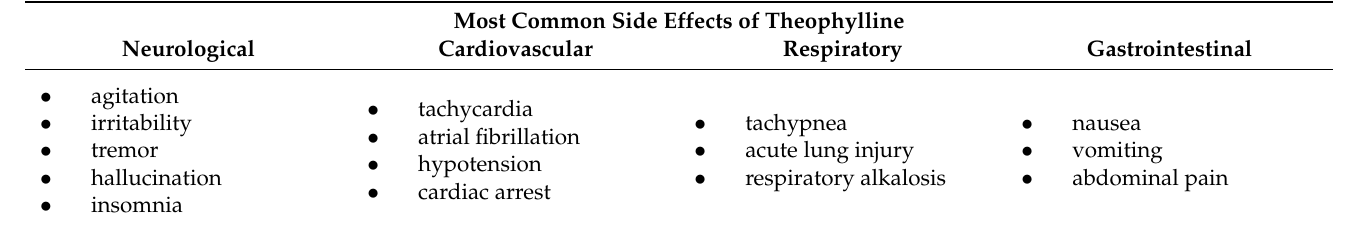
Table 8. The most common side effects of theophylline